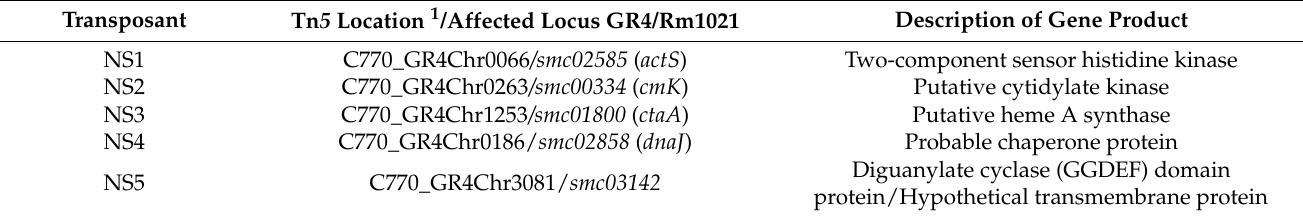
Table 1. GR4flaAB-derived mutants insensitive to volatile